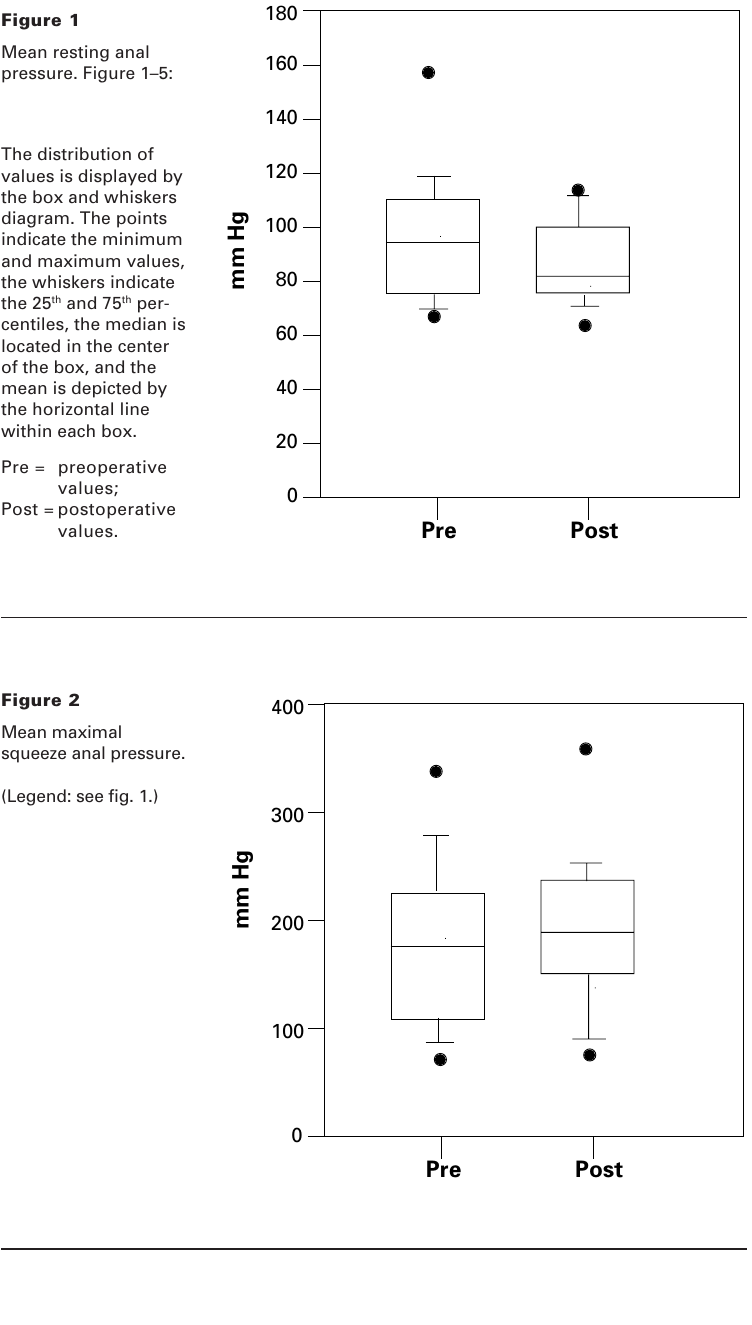
Mean resting anal pressure. Figure 1–5: